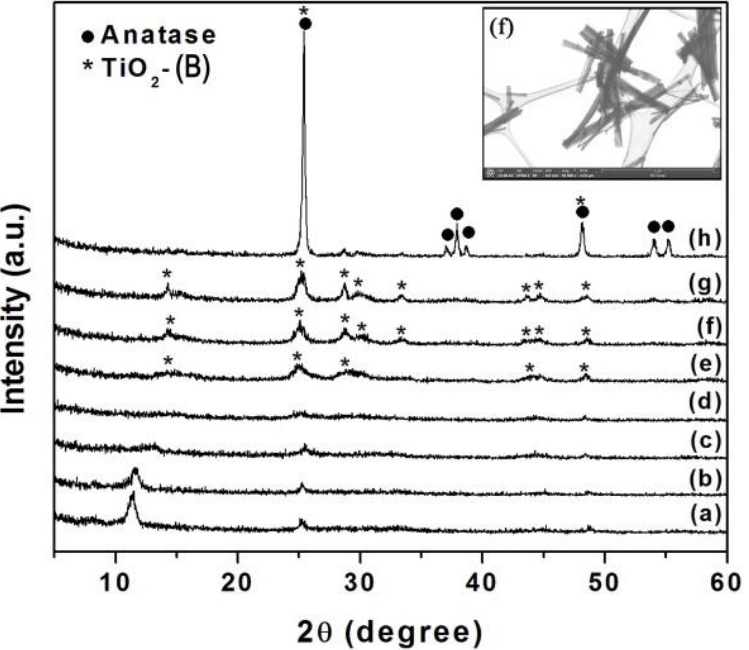
Figure 2. XRD patterns of TiO 2 -related nanowires prepared for 120 h at 150 °C ( a ) as-synthesized, and post-heat treatments calcination for 2 h at ( b ) 100 °C, ( c ) 200 °C, ( d ) 300 °C, ( e ) 400 °C, ( f ) 500 °C, ( g ) 600 °C and ( h ) 700 °C. Peaks corresponded to anatase and TiO 2 (B) are indicated as “•” and “*”, respectively. In inset of figure, a STEM image of TiO 2 (B) nanowires, corresponding to sample ( f ) is displayed.